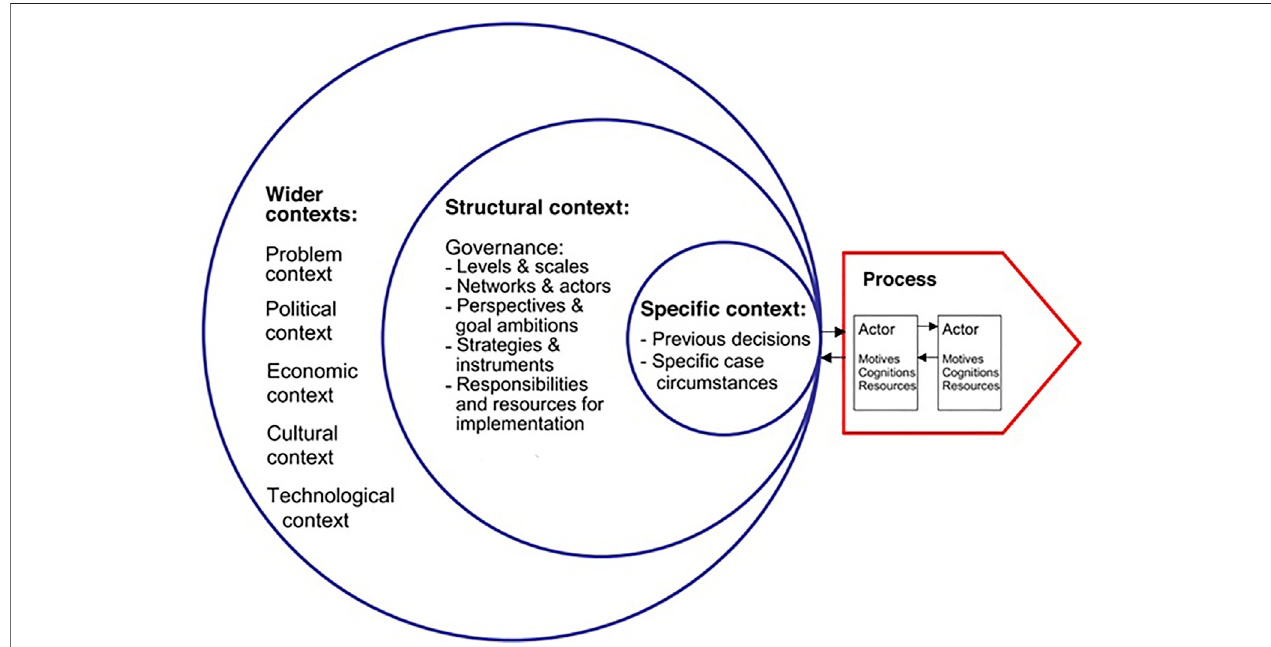
FIGURE 1 | Contextual Interaction Theory elements (Bressers, 2004).